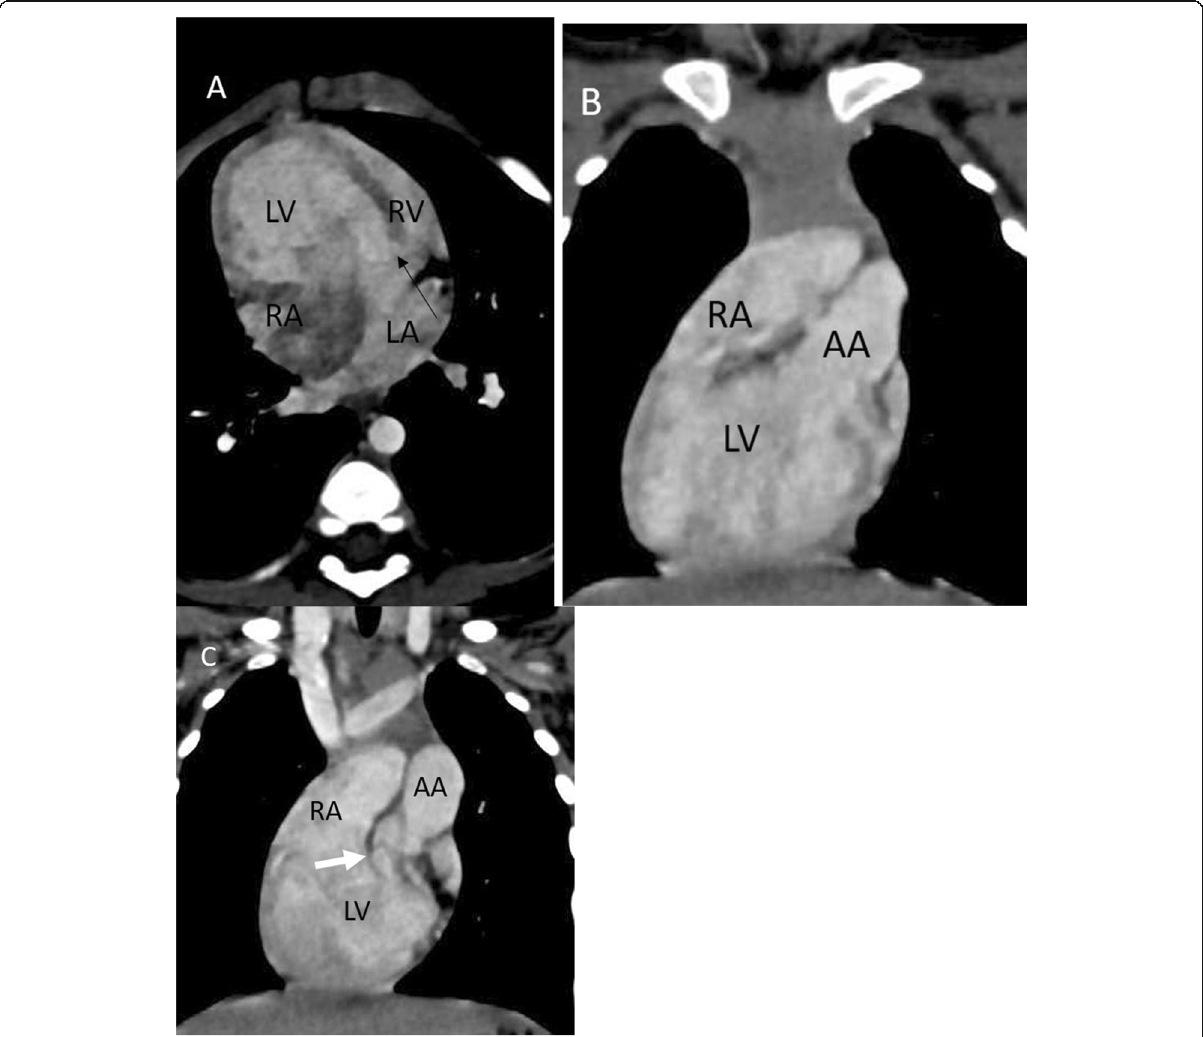
Fig. 2 A 2-year-old boy presented with respiratory distress and low O2 saturation. a Axial CTA shows dextrocardia, hypoplastic RV, dilated double inlet LV receives both atria, and VSD (arrow). b Coronal CTA shows aorta arises from the enlarged LV. c Coronal CTA shows small